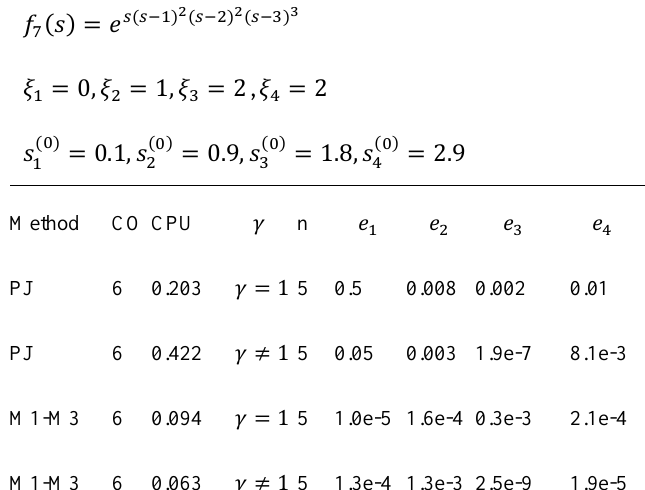
Simultaneous determination of all roots (𝑠) = 𝑒 𝑠(𝑠−1) 2 (𝑠−2) 2 (𝑠−3) 3 𝑓 7